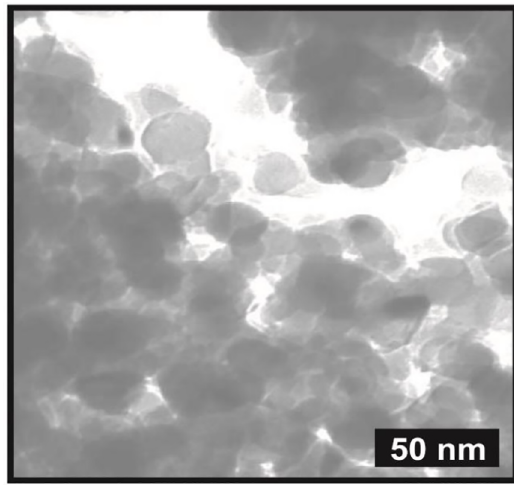
O nanoparticles. 2 4